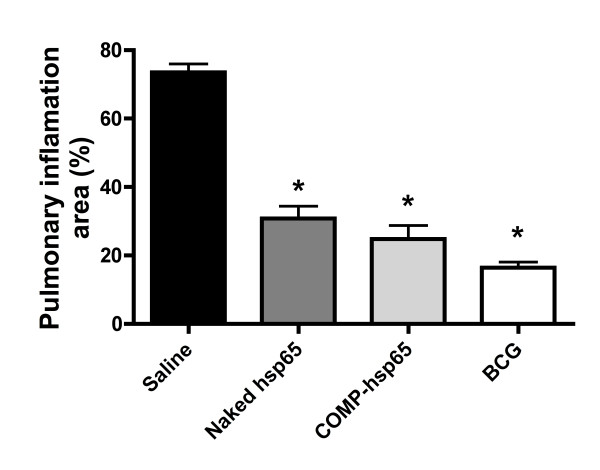
Morphometric analysis of lung parenchyma from mice immunized with COMP-hsp65 or naked hsp65. We performed morphometric analysis of lung histology sections. Data represent the mean percent of pulmonary area committed to inflammation ± SD of six mice per group of one of three independent experiments. *p < 0.01 were considered significant when compared to the saline group.